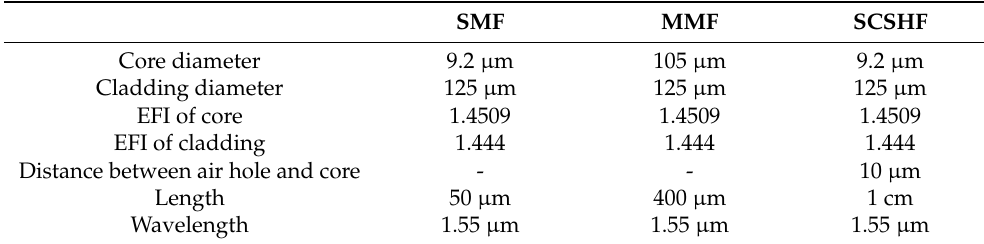
Figure 6. ( a ) Simulation model of the SCSHF sensor; ( b ) Optical field distribution in the SCSHF sensor; ( c ) Relative value of light intensity in the SCSHF sensor.